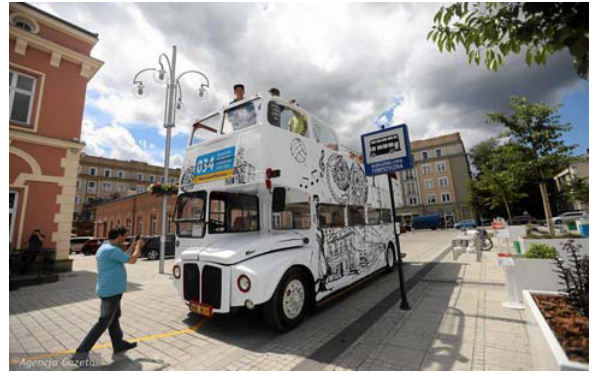
Fig. 3. Tourist bus service – July-August